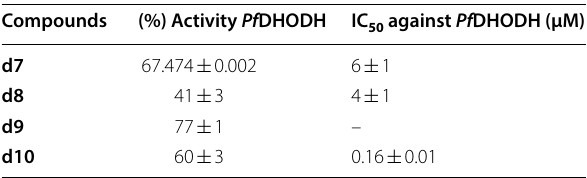
Table 35 In vitro antimalarial activity results of active compounds Compounds